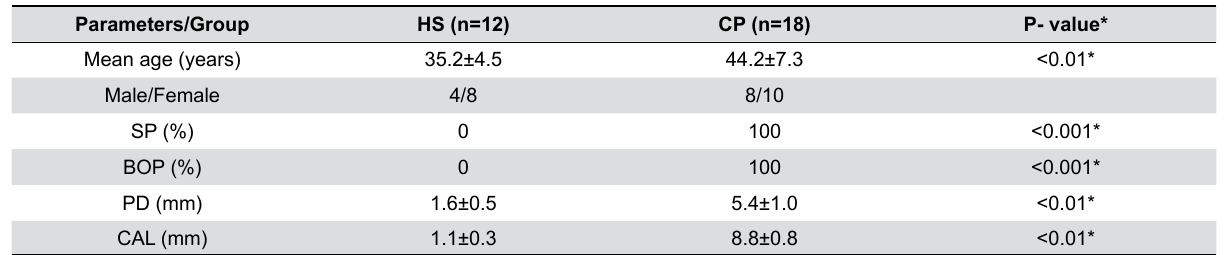
Table 1- Mean±S.D. and percentages of demographic and clinical data from patients with chronic periodontitis (CP) and healthy subjects